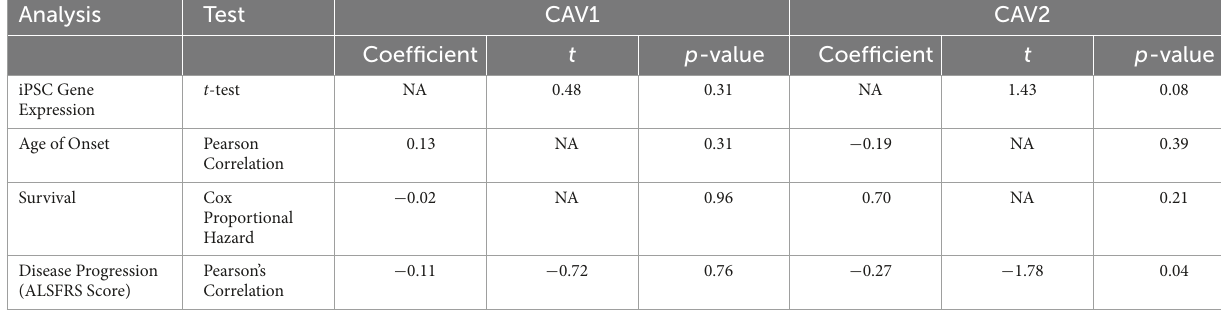
TABLE 3 Results of AnswerALS RNA-seq expression and phenotypic correlation analyses for CAV1 (blue) and CAV2